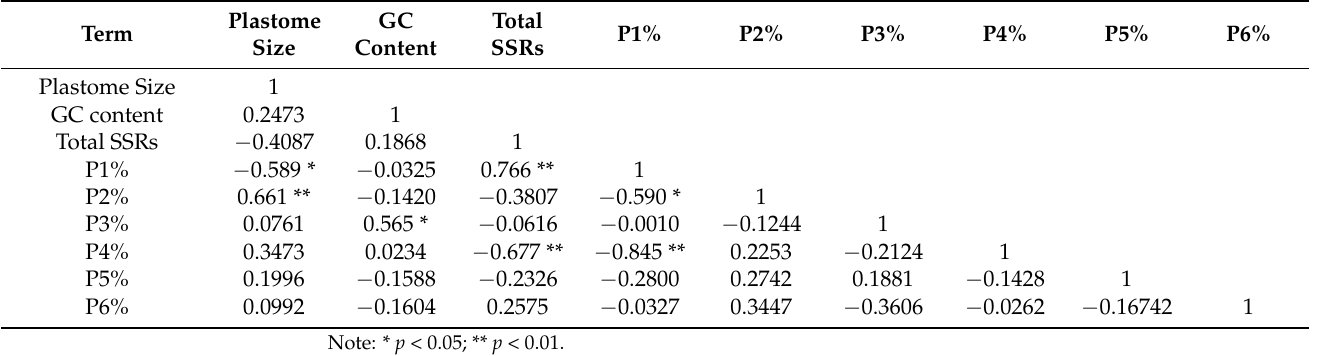
Table 4. The codon usage of 16 Aristidoideae plastomes.